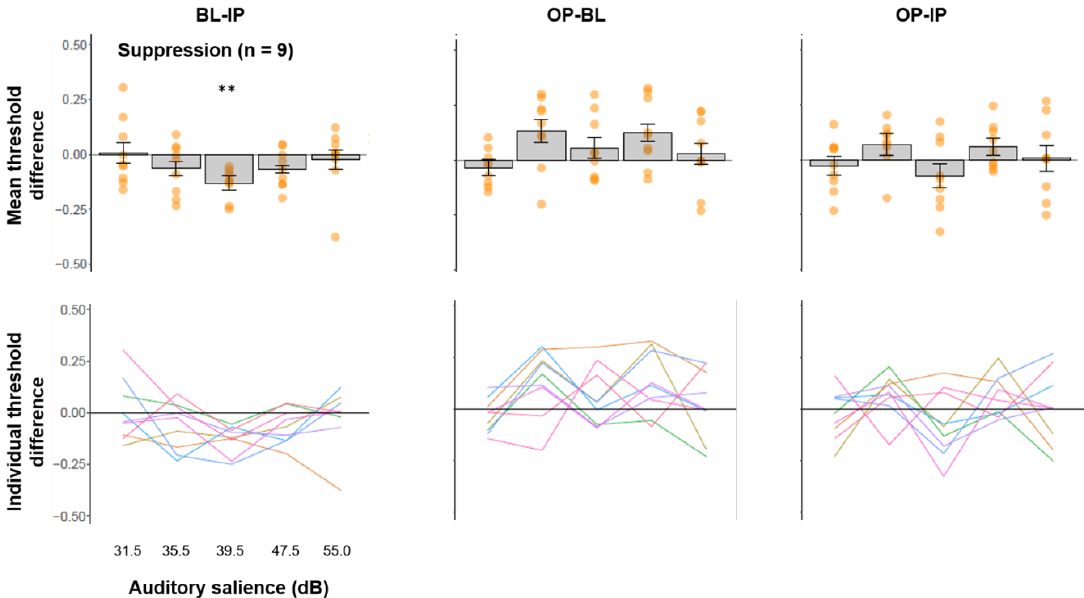
Figure 5. (Top panel) Mean threshold difference (+/− SE) and (bottom panel) trends line for individual participants across three comparisons from the suppression group. **: p < 0.01. Table1. Thenumberof participantsshowingpeakIP benefit relative toBLateach auditory